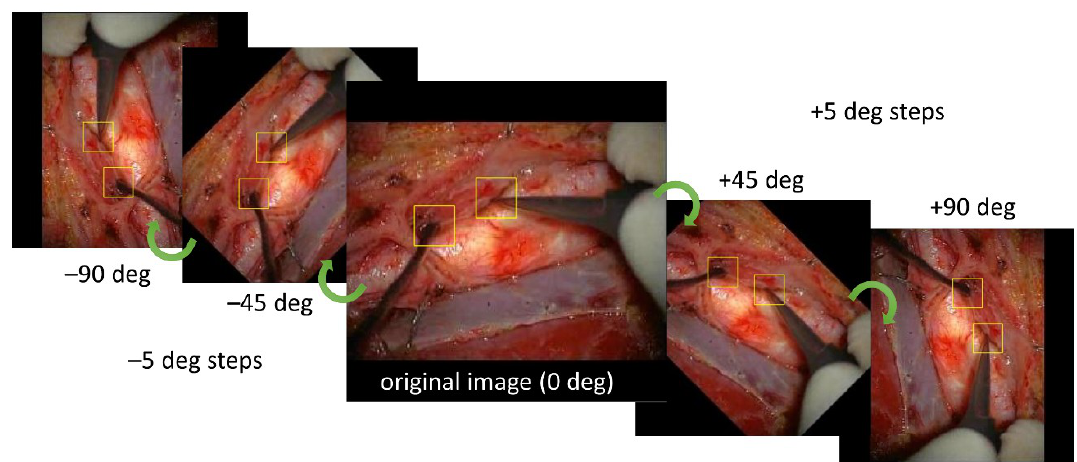
Figure 5. Data augmentation of the training datasets. The original images and supervised bounding boxes were rotated from –90° to 90° in 5° steps.